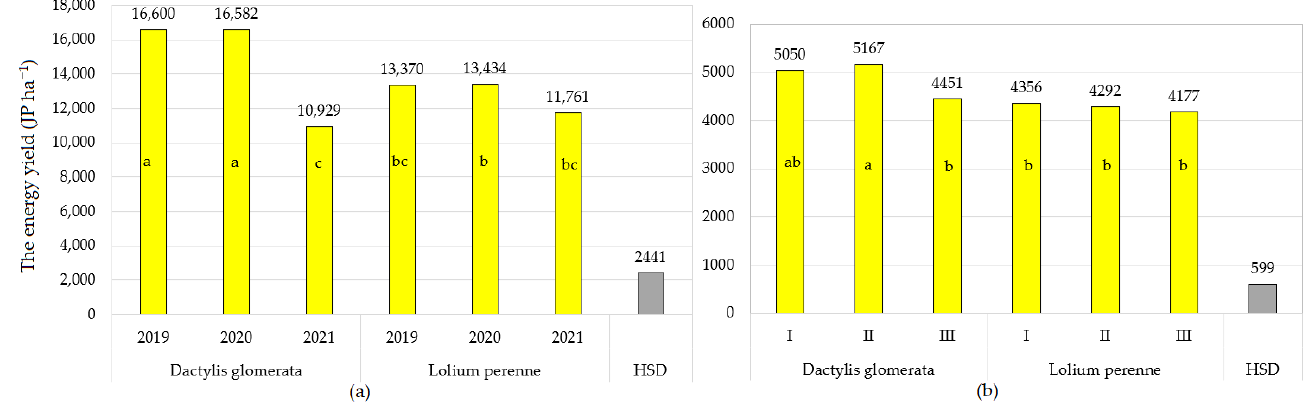
Figure 3. The energy yield of Dactylis glomerata and Lolium perenne in consecutive ( a ) growing seasons and ( b ) harvests (JP ha − 1 ).